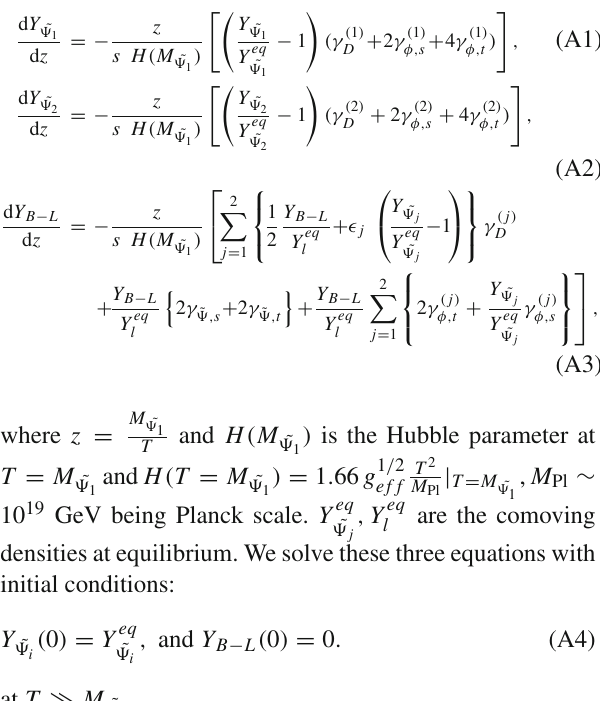
scattering via Higgs (contributes to γ 1 φ, scattering via ˜ (cid:9) 1 ( ˜ (cid:9) 2 ) (contributes to γ ˜ (cid:9),